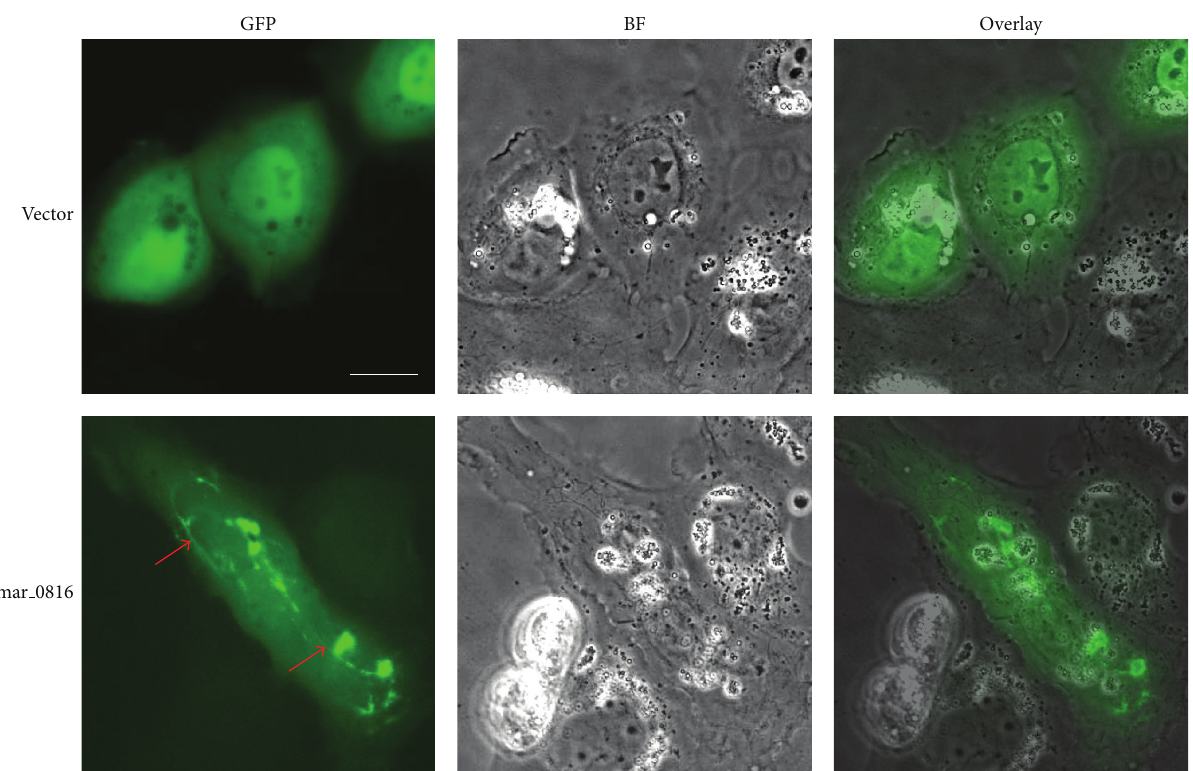
Figure 2: Nmar 0816 forms filament-like structures in mammalian cells. Images of mammalian NRK cells expressing GFP-Nmar 0816. Red arrows point to filament-like structures. BF: bright field; Scale bar: 7 𝜇